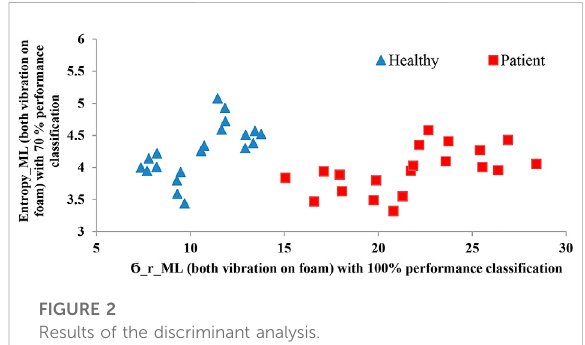
FIGURE 2 Results of the discriminant analysis.